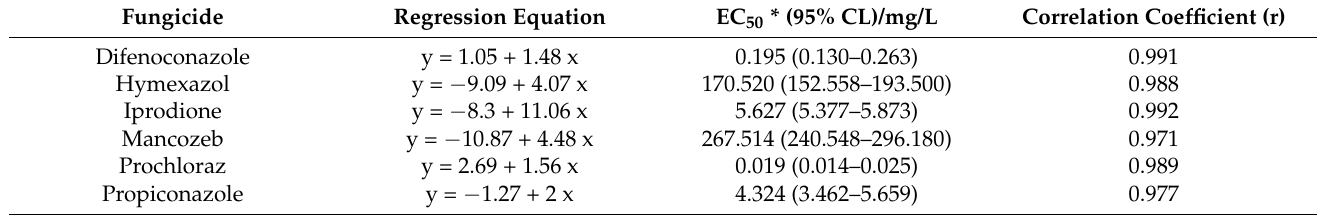
Table 2. Toxicity of six fungicides against the mycelial growth of Arthrinium arundinis isolate BBB1.